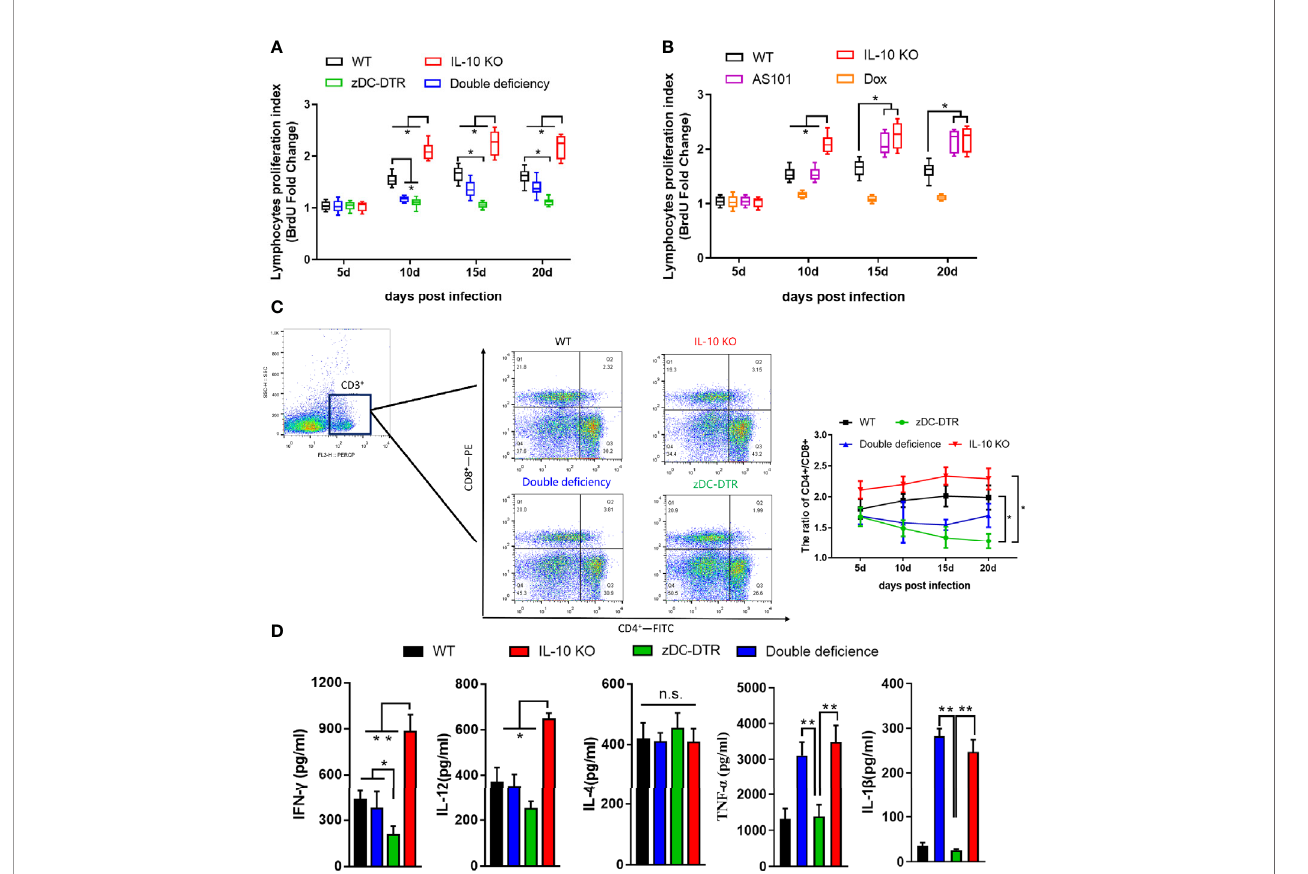
FIGURE 4 | Lymphocyte proliferation, T cell subsets, and cytokines in sera post infection. (A) BrdU assay detection of lymphocyte proliferation in Experiment I. Compared with WT mice, lymphocyte proliferation was signi fi cantly decreased in DD mice at 10 dpi. Afterward, lymphocyte proliferation gradually increased in DD mice to the levels observed in WT mice. (B) Higher lymphocyte proliferations were determined in AS101-treated mice compared with those of WT mice from day 15 to day 20. (C) Flow cytometry examination of T cell subsets (CD3-PE-cy5, CD4-FITC, and CD8-PE) at 5, 10, 15, and 20 dpi. CD4 and CD8 were analyzed by pre- gated CD3 + cells. A higher proportion of CD4 + /CD8 + was observed in IL-10 − / − and WT mice compared with zDC-DTR mice from 15 to 20 dpi. However, the T cell subset ratio in DD mice began to gradually increase at 15 dpi and showed no signi fi cant difference from that of WT mice at 20 dpi. (D) Cytokines (IFN- g , IL-12, IL-4, TNF- a , and IL-1 b ) in sera were detected using commercial ELISA kits. All data were expressed as the mean ± SD (n=5 sera per group). Differences were analyzed by ANOVA (* P <0.05, ** P <0.01, n.s., no statistical signi fi